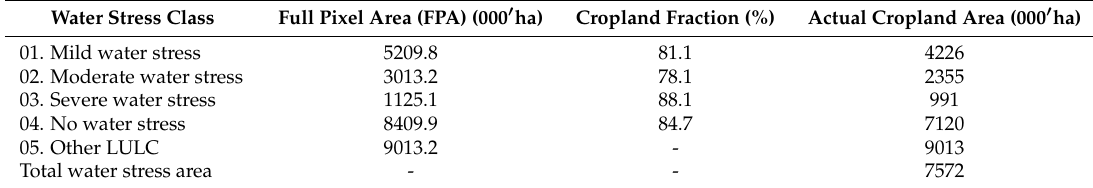
Table 3. MODIS-derived water stress areas across the Krishna River Basin. The table shows full-pixel area (FPA), crop area fraction (CAF), and sub-pixel area (SPA) or actual area. SPA = FPA × CAF.